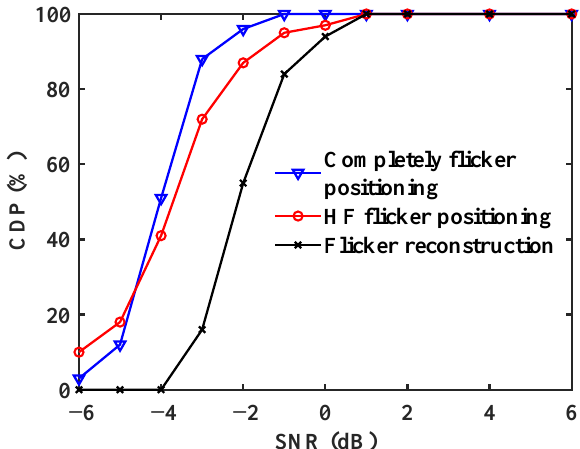
Figure 16. CDP of the SVD time domain location.